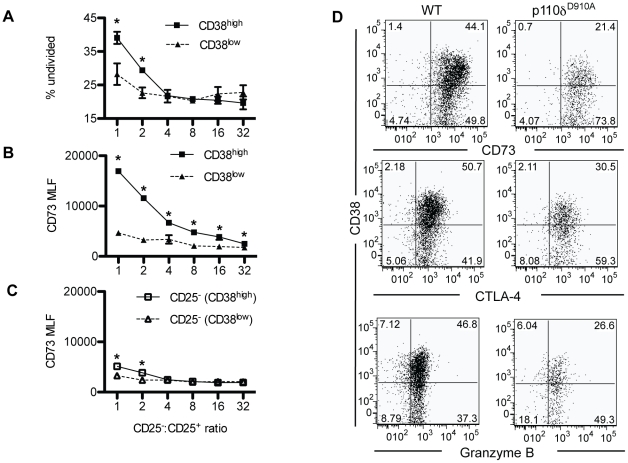

In vitro suppression of T cell proliferation by CD38high and CD38low Treg.A. Proportion of undivided CD4+CD25− after three days culture with CD38high or CD38low CD4+CD25+ Tregs. B. Expression of CD73 by CD38high and CD38low Tregs after suppression. C. Expression of CD73 by CD4+CD25− cells after suppression by either CD38high or CD38low Treg. D. Expression of CD38 versus CD73, CTLA-4 and Granzyme B on CD4+CD25+Foxp3+ cells from WT and p110δD910A Treg cells.